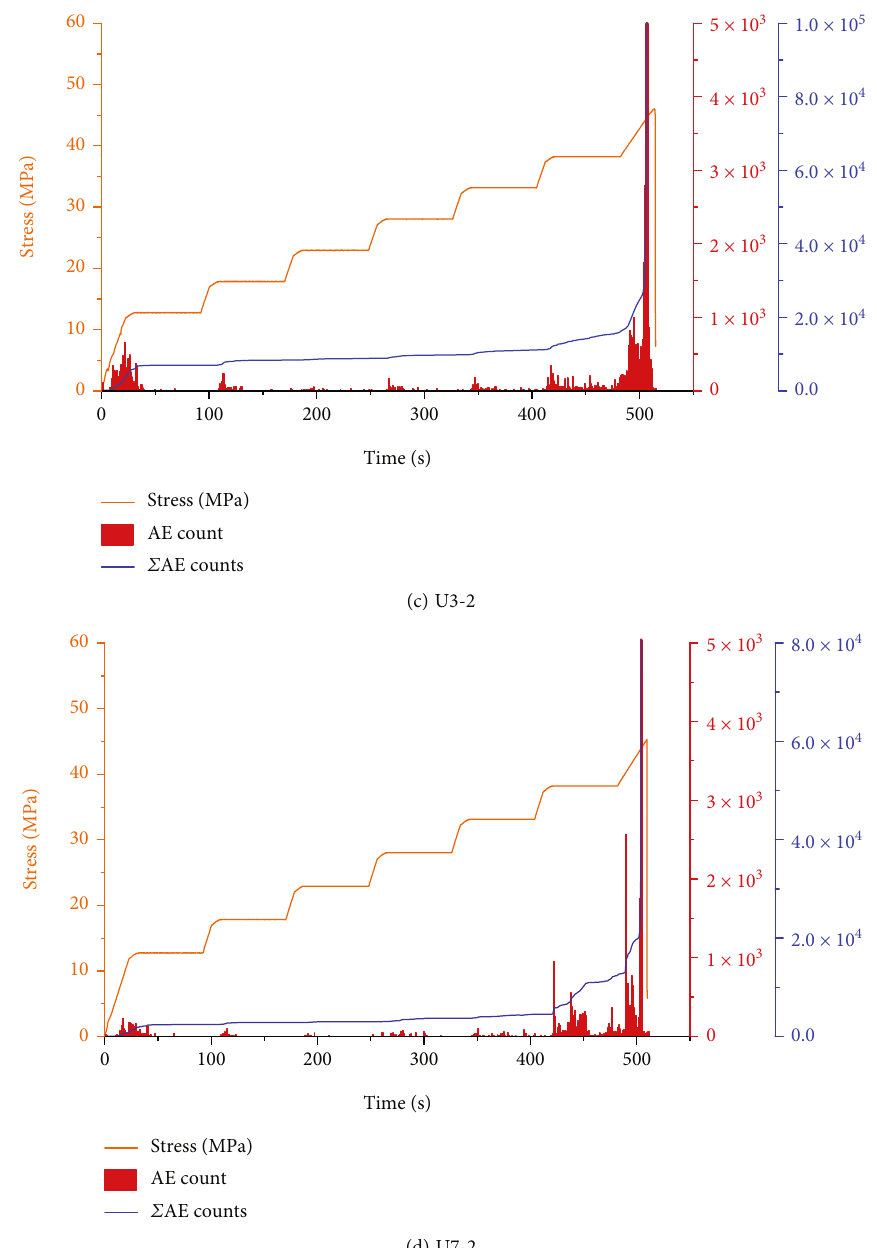
Figure 3: Relationships of stress, AE counts, and cumulative AE counts with time in the uniaxial compression test for di ff erent moisture